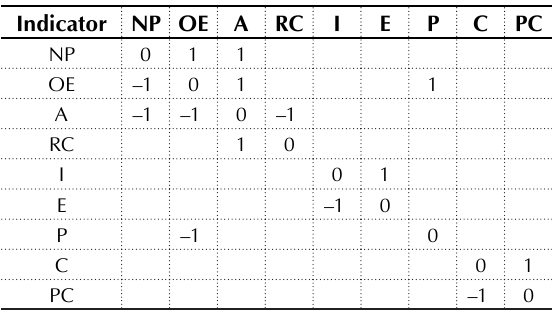
Table 2. The matrix of reference preferences Table 4. The matrix of actual ratios of the banking system performance indicators in 2013–2015